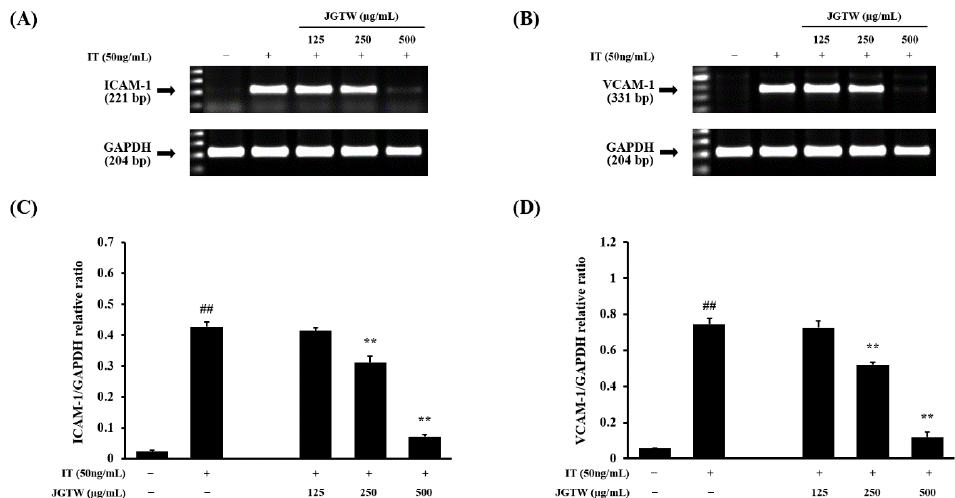
Figure 5. Effect of JGTW on the expression of adhesion molecules in BEAS-2B cells. RT-PCR was performed to analyze the expressions of ICAM-1 and VCAM-1 after 48 h IT (50 ng/mL) treatment with or without JGTW pretreatment in BEAS-2B cells. The representative photographs of ICAM-1 ( A ) or VCAM-1 ( B ) expressions, and band intensities of ICAM-1/GAPDH ( C ) or VCAM-1/GAPDH ( D ). The values are presented as mean ± SEM. ## p < 0.01 versus vehicle-treated cells; and ** p < 0.01 versus IT-treated cells.